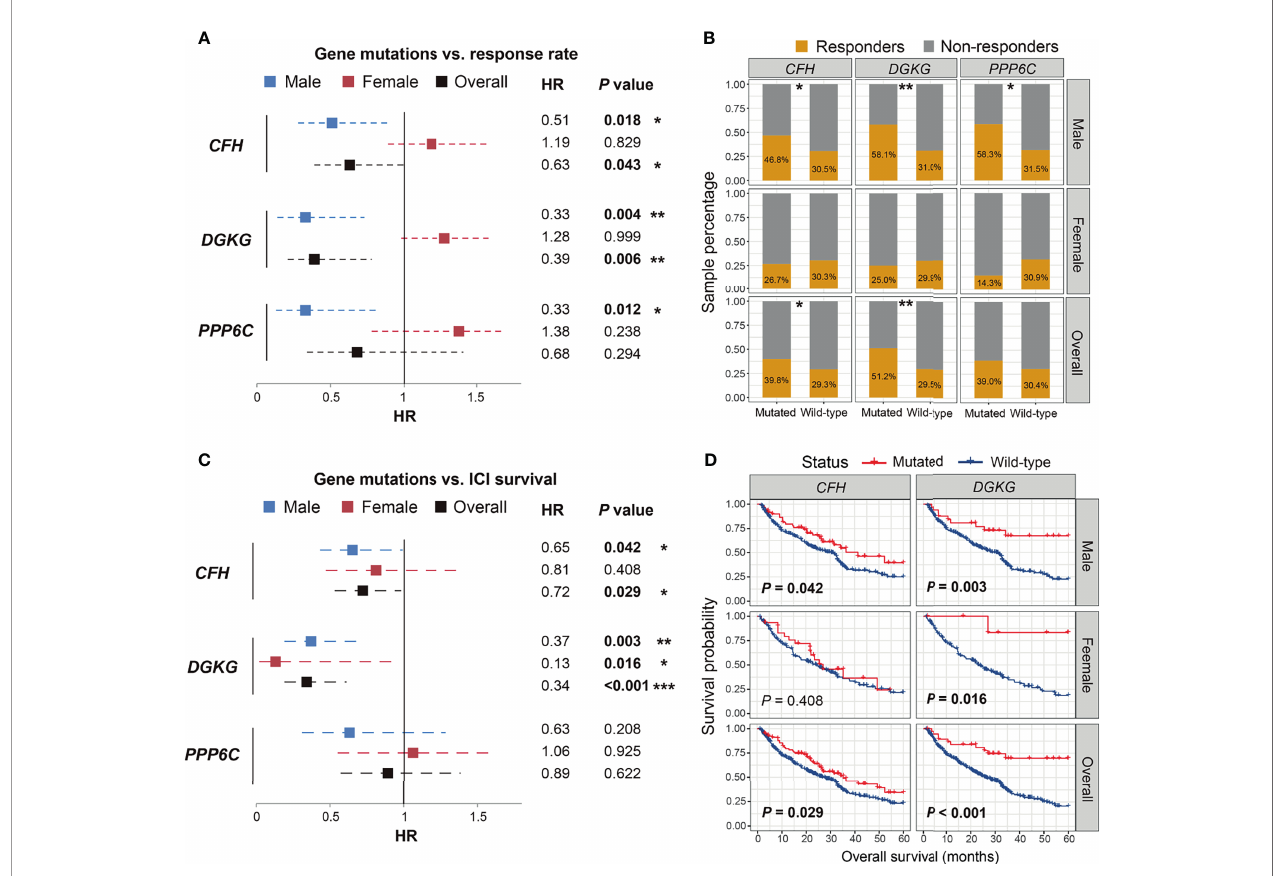
FIGURE 2 | Association of CFH , DGKG , and PPP6C mutations with immune checkpoint inhibitor (ICI) response rate and overall survival bene fi ts in distinct sex groups. (A, B) Forest plot and bar plot representations of the association of SMG mutations with ICI response rate in distinct sex groups. (C, D) Forest plot and survival plot representations of the association of SMG mutations with ICI survival outcome in distinct sex groups. * P < 0.05; ** P < 0.01; *** P <